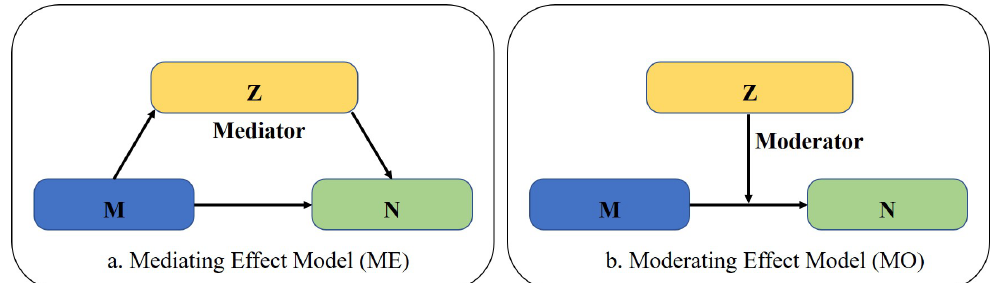
Figure 5. Mediating effect model map ( a ) and moderating effect model map ( b